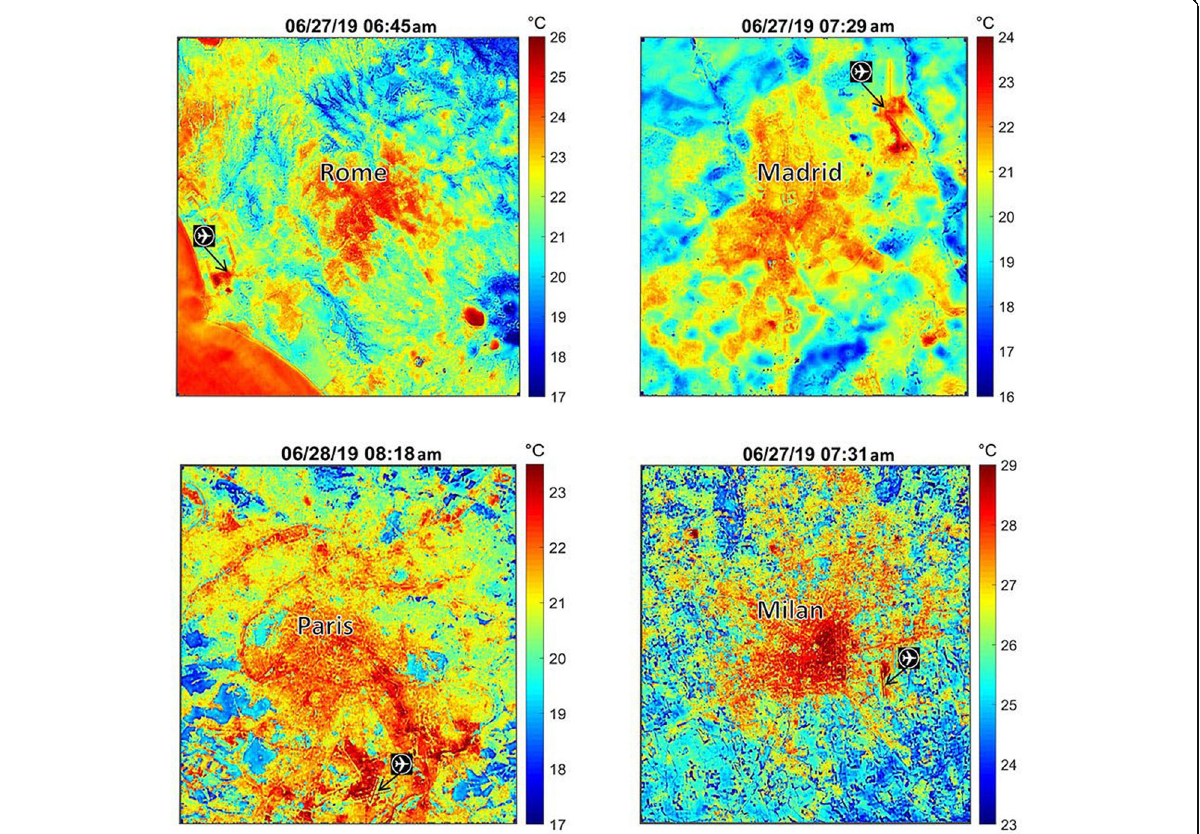
Fig. 20 Early morning temperatures (between 06:45 and 08:18) over four European city centers (top row: Rome and Madrid); bottom row: Paris and Milan), measured by ECOSTRESS on 27 and 28 June during the 2019 heat wave. Urban temperatures were 6 – 9 °C hotter than temperatures in the surrounding areas (blue/aqua/green shades). Images were sharpened to delineate airports. Figure from NASA/JPL-Caltech.